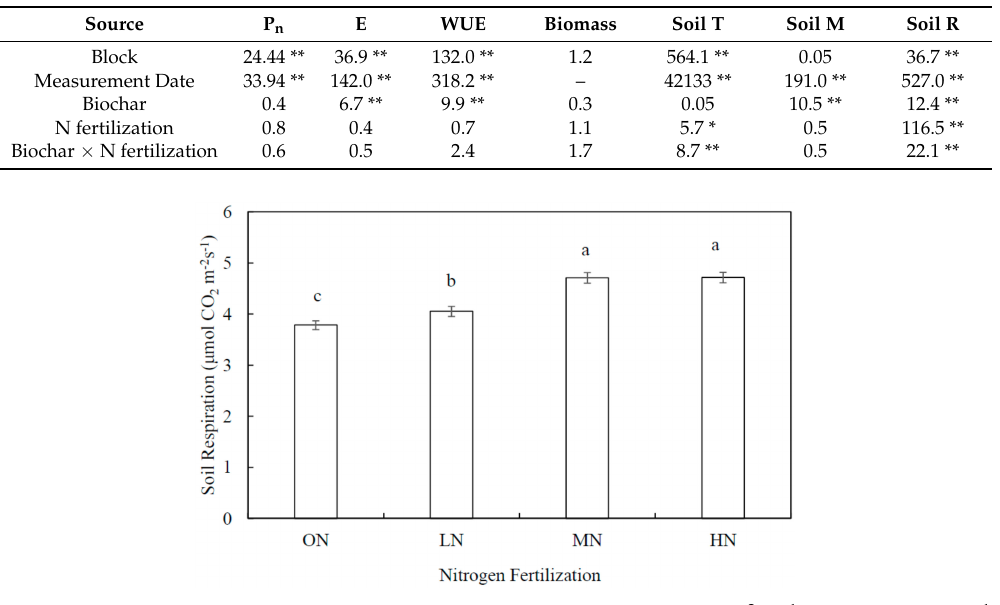
Figure 1. Effects of nitrogen fertilization on soil respiration ( µ mol CO 2 m − 2 · s − 1 ). ON: 0 kg N ha − 1 ; LN: 17 kg N ha − 1 ; MN: 34 kg N ha − 1 ; and HN: 67 kg N ha − 1 . Each value is calculated from 160 pot measurements from two blocks in both the control and biochar treatments. Error bars are standard errors of means. Means with different labels are significantly different at α = 0.05